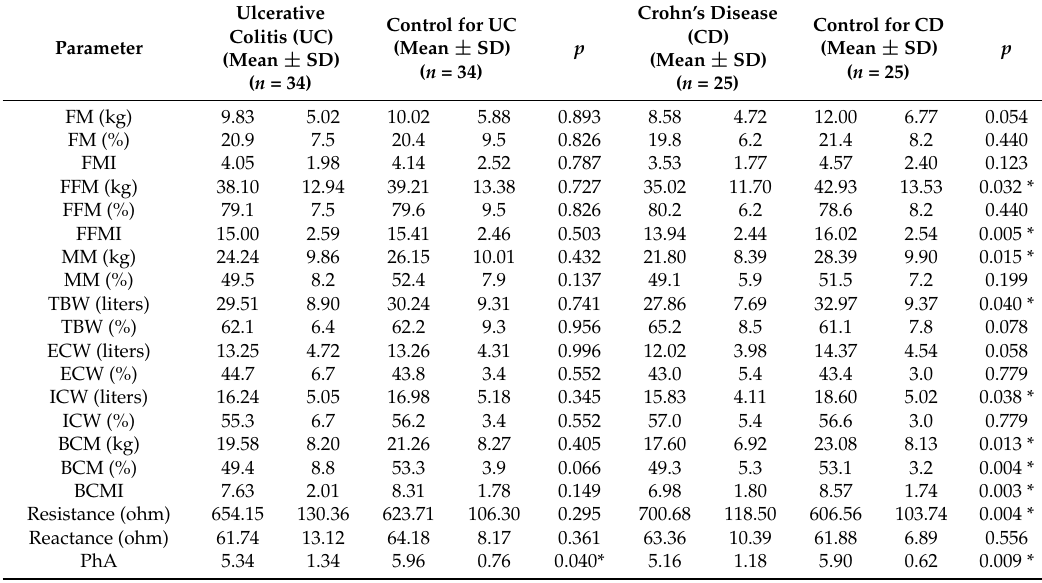
Table 2. Bioelectrical Impedance Analysis results in study